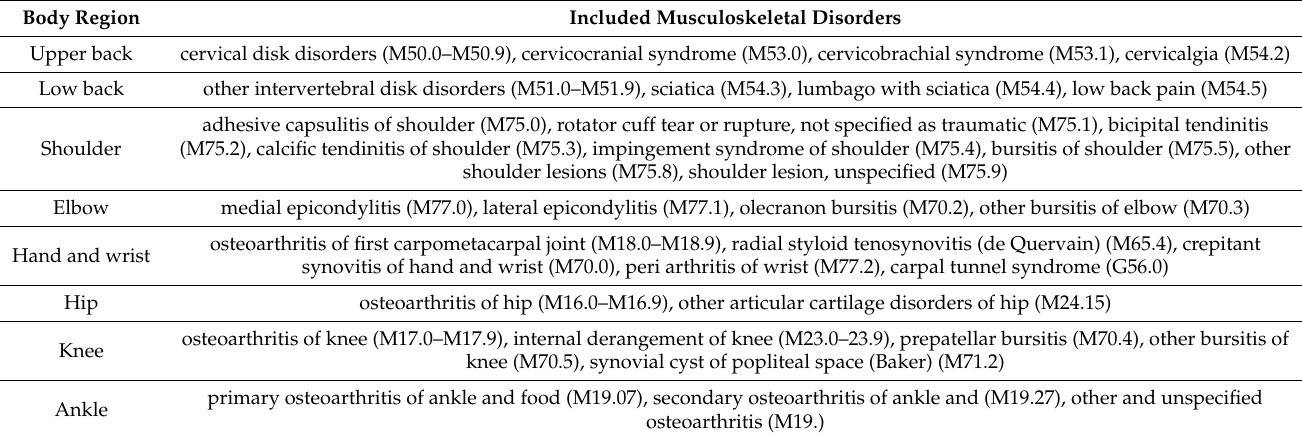
Table 1. List of the most common work-related musculoskeletal disorders included in the study by body region. Included Musculoskeletal